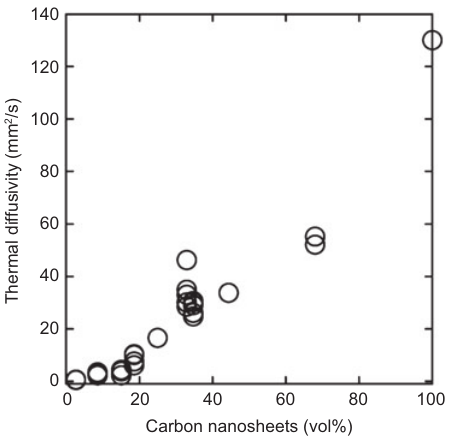
Figure 9 Dependence of the observed thermal diffusivity on the carbon-nanosheet (GN) loading in the epoxy-nanocomposite thin fi lms. (Reproduced from Ref. [81] with permission from Wiley-VCH Verlag GmbH & Co. KGaA, Weinheim.)